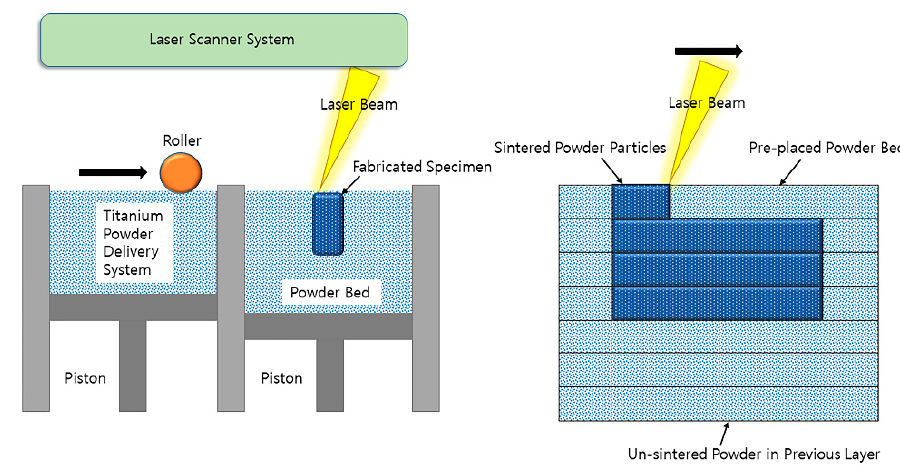
Materials 2021 , 14 , 3892 Figure 1. Selective laser melting type 3D-printing process of highly porous titanium specimens. Figure 1. Selective laser melting type 3D ‐ printing process of highly porous titanium specimens.